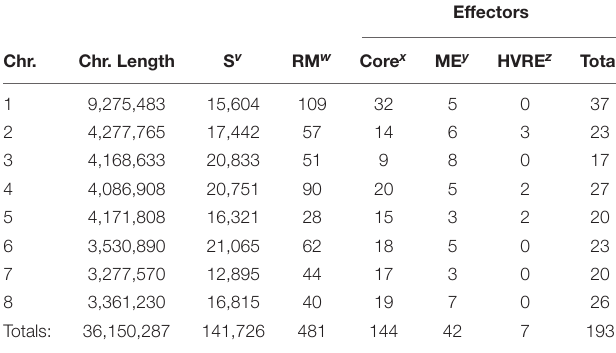
v Polymorphic nucleotide sites on chromosome. w Sites of nucleotide recombination on chromosome. x Core effectors found in all 19